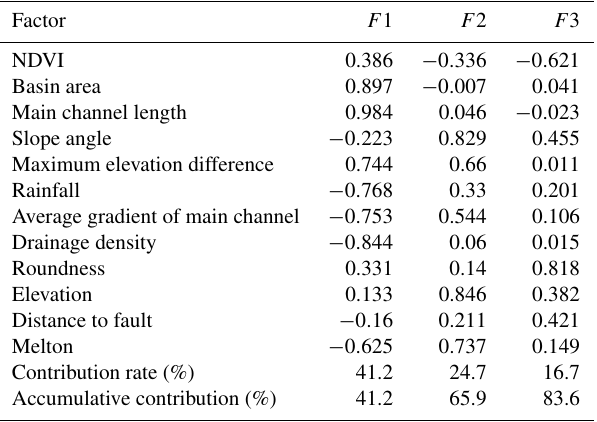
Table 7. The correlation coefficients between common factors and primitive